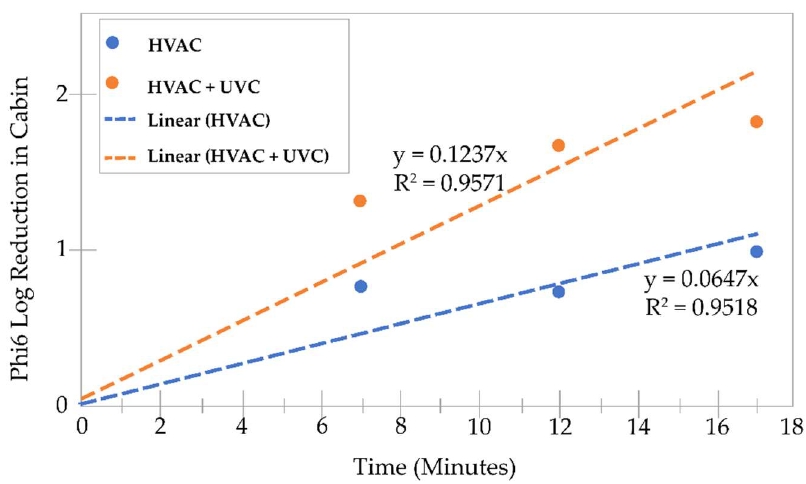
Figure 7. A graph of the log reduction in the chamber vs. time. The HVAC + UVC obtained more than 90% viral reduction faster than HVAC only.